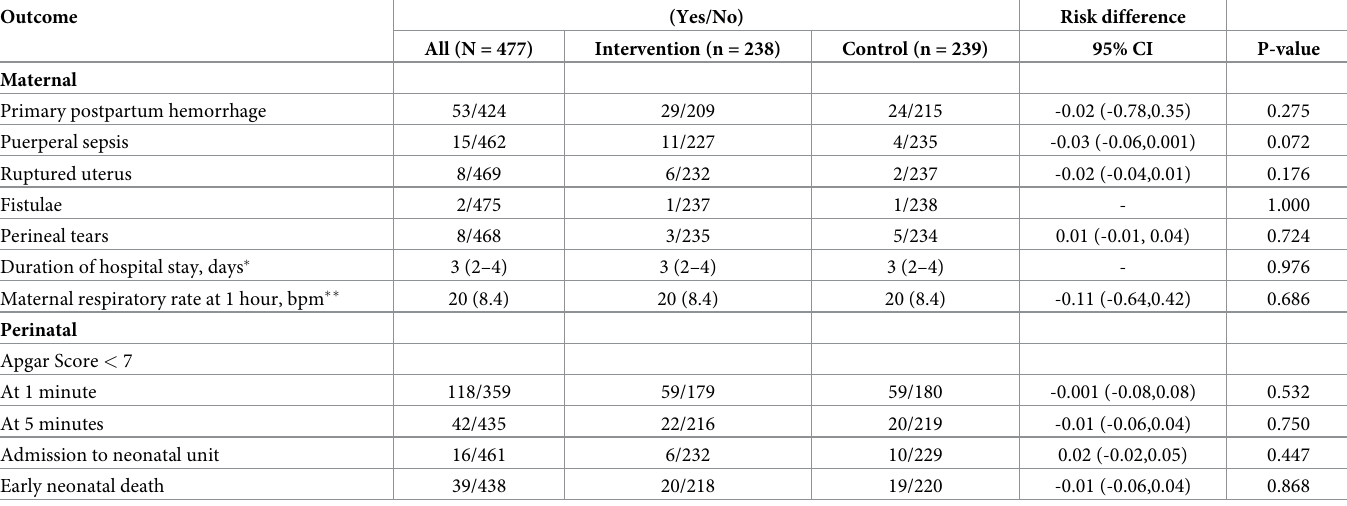
Table 3. Secondary clinical outcomes among women with obstructed